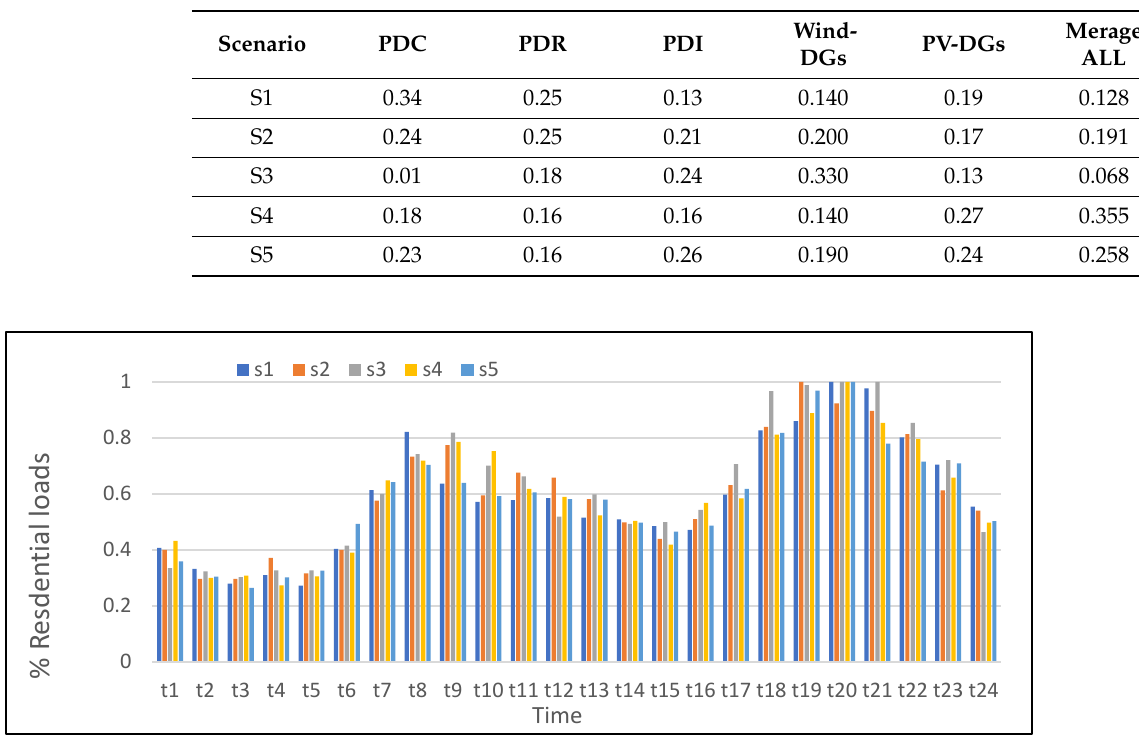
Figure 6. Daily demand profiles for residential loads.